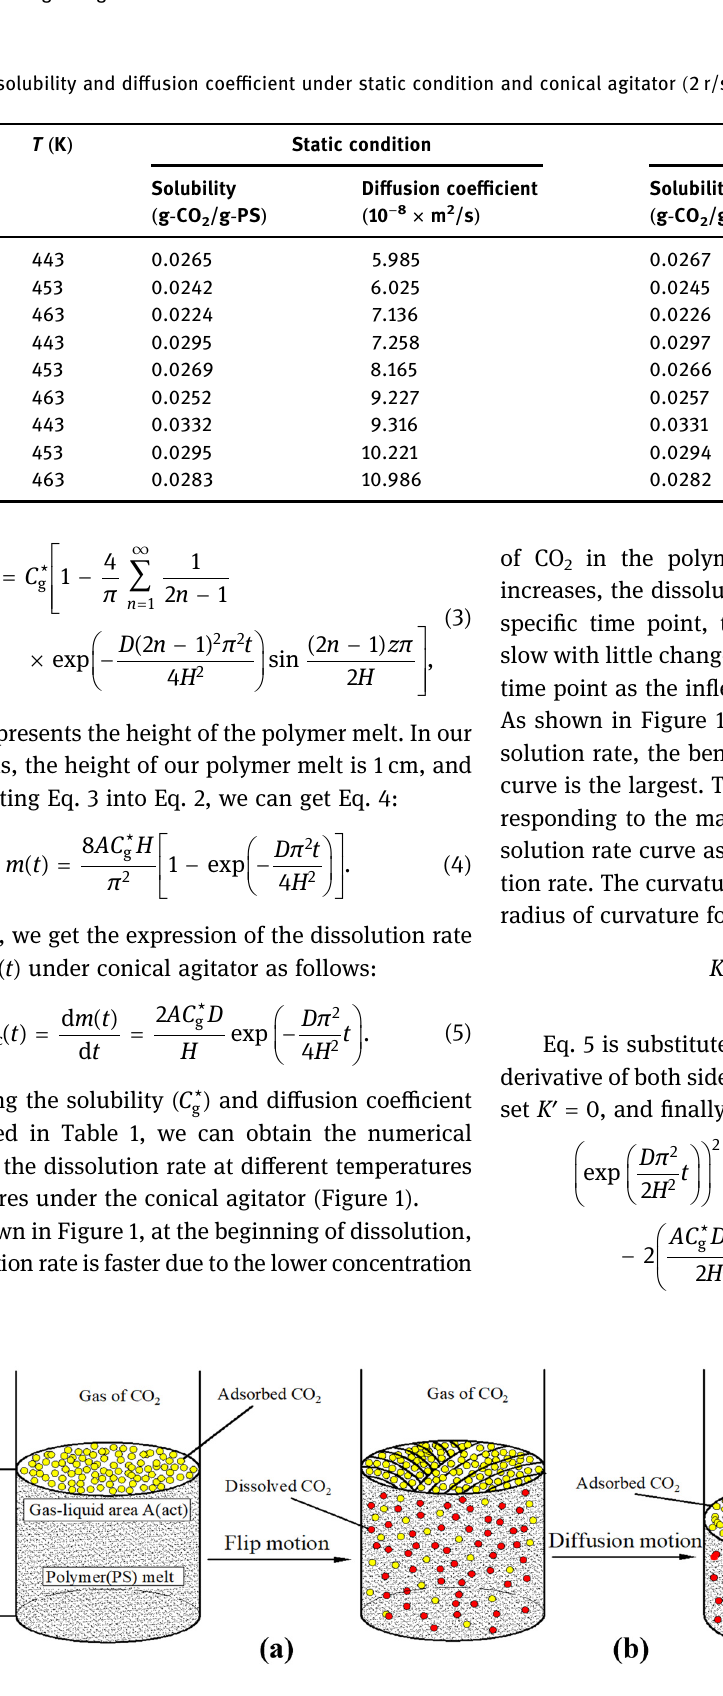
Figure 3: Dissolving process under interface fl